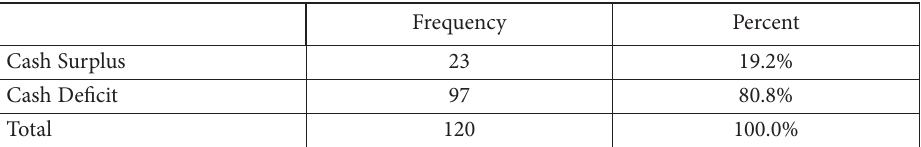
Table 5. Absolute and relative frequencies of polarity in the case of needed cash (source: author based on Bisnode